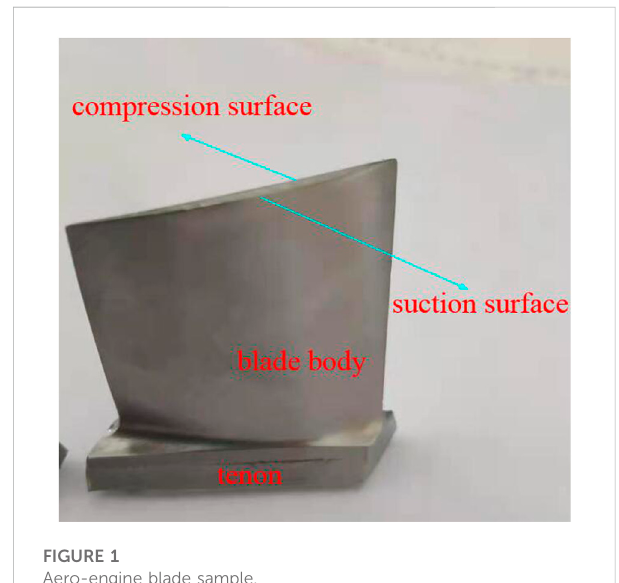
FIGURE 1 Aero-engine blade sample.